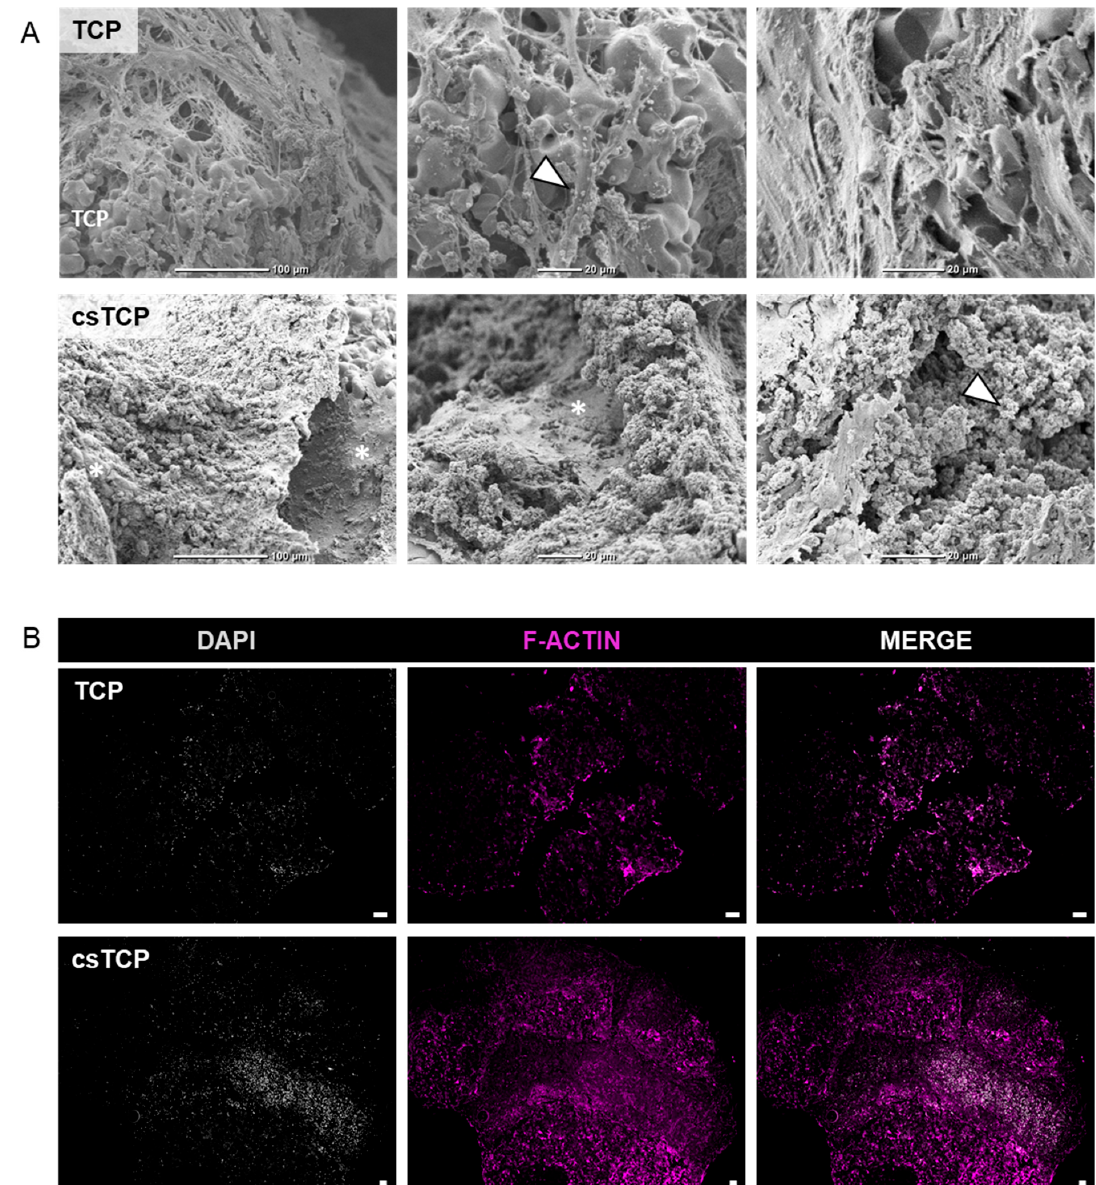
Figure 2. Comparing csTCPs and MSC-populated TCPs regarding cell density and morphology. ( A ) Exemplary SEM images at three magnifications highlighting cell adhesion, ECM content, pheno- typic features at day 21 comparing TCP and csTCP. Cells well adhered to and spread on the surfaces of β -TCP. ( B ) Immunofluorescence staining for F-actin and DAPI to visualize cell density through the β -TCP particles. Exemplary images for n = 5. Scale bars show 100 µm. Legend: asterisk = high- lighting ECM; arrow = highlighting microstructure deposition; TCP = highlighting the scaffold ma- terial.